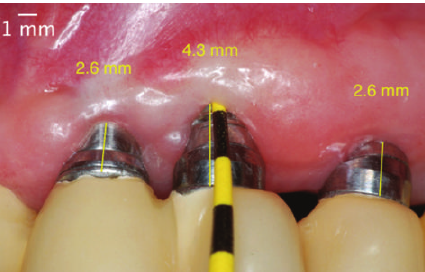
Figure 9: Immediate postoperative aspect after subepithelial con- nective tissue graft.